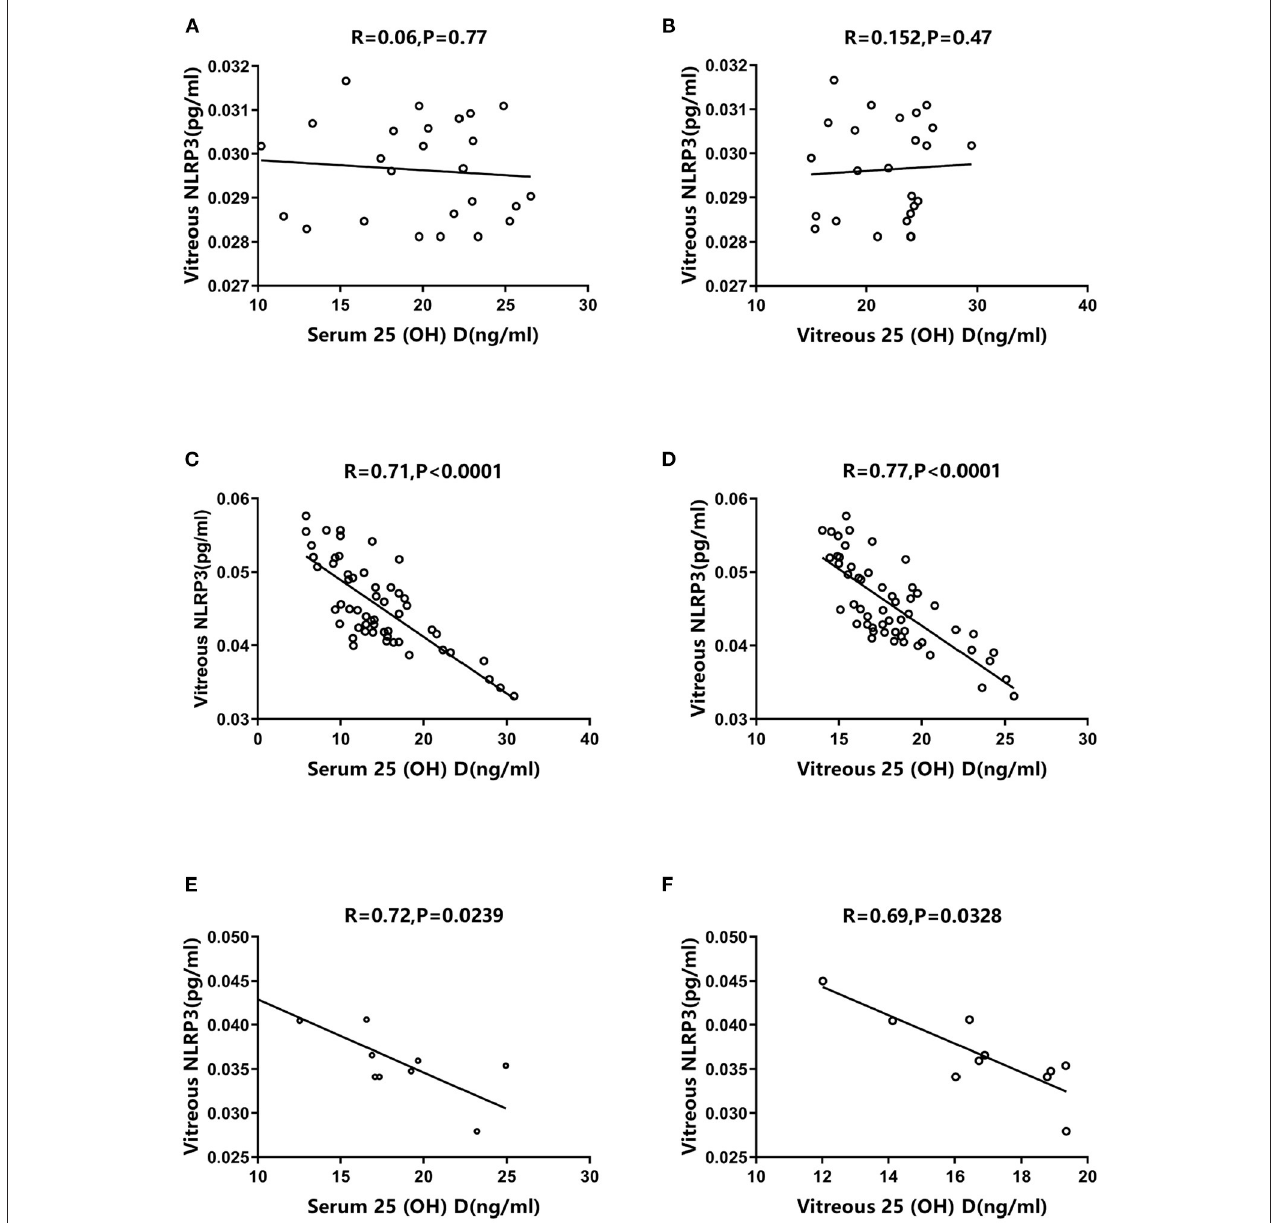
FIGURE 4 | Correlations between vitreous NLRP3 levels and serum/vitreous 25 (OH) D concentrations. Spearman’s correlation tests exhibited no significant correlations (A) between vitreous NLRP3 level and serum 25 (OH) D concentration in control group ( R = 0.06, P = 0.77), and (B) between vitreous NLRP3 level and vitreous 25 (OH) D concentration in control group ( R = 0.152, P = 0.47). Spearman’s correlation tests presented negatively significant correlations (C) between vitreous NLRP3 level and serum 25 (OH) D concentration in PDR group ( R = 0.71, P < 0.0001), (D) between vitreous NLRP3 level and vitreous 25 (OH) D concentration in PDR group ( R = 0.77, P < 0.0001), (E) between vitreous NLRP3 level and serum 25 (OH) D concentration in NPDR group ( R = 0.72, P = 0.0239) and (F) between vitreous NLRP3 level and vitreous 25 (OH) D concentration in NPDR group ( R = 0.69, P = 0.0328).